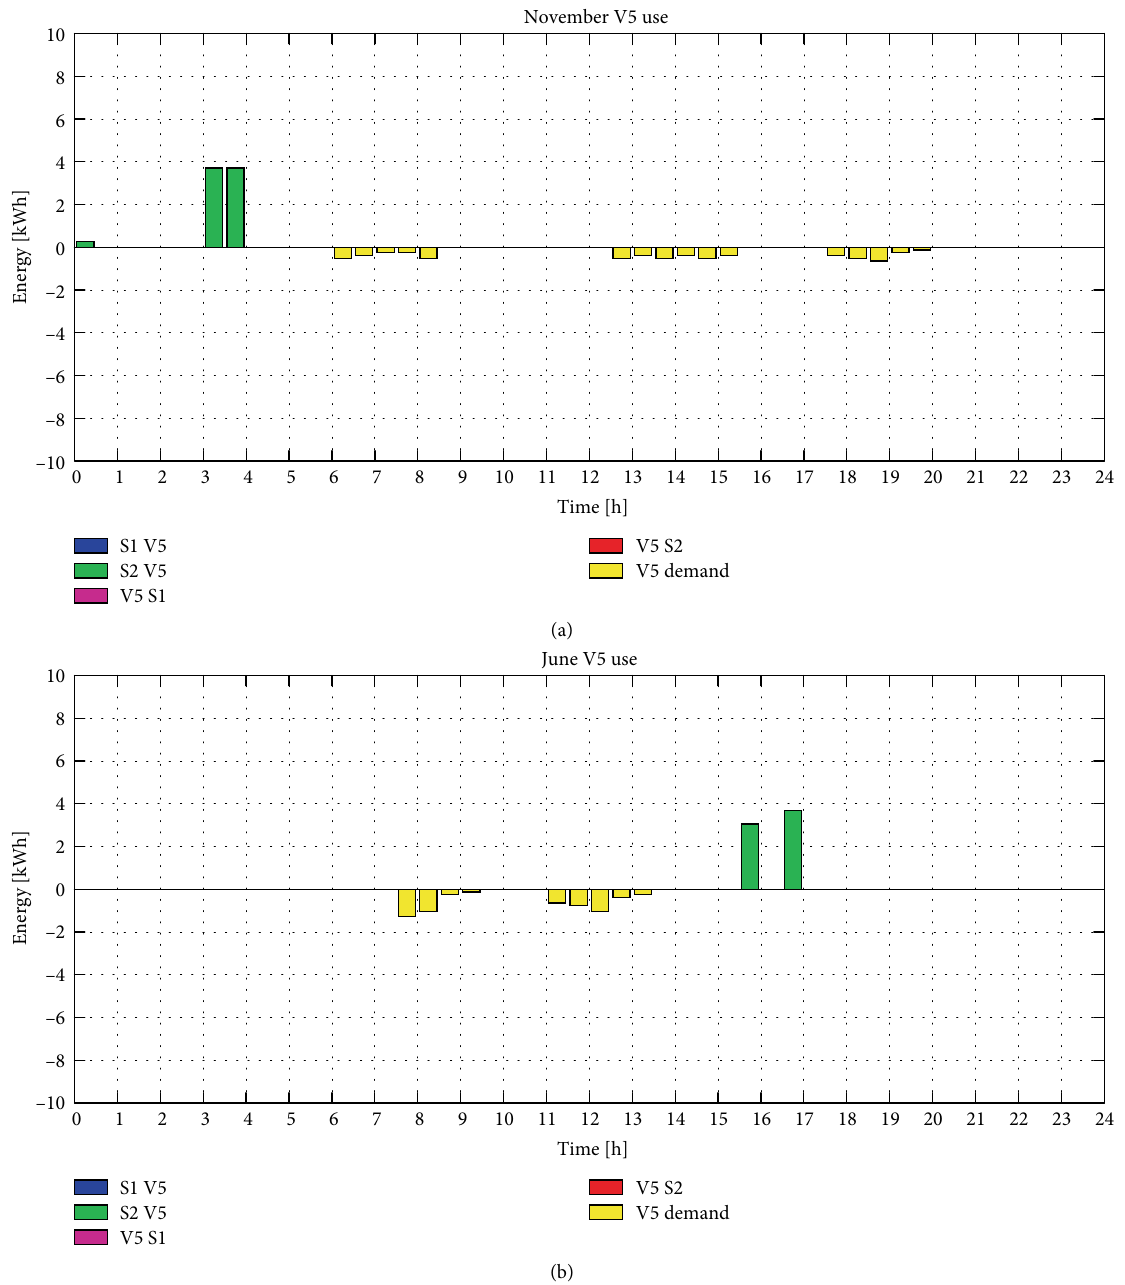
Figure 4: (a) November day electrical profiles for one “Nissan Leaf” in Case 4. (b) June day electrical profiles for one “Nissan Leaf” in Case